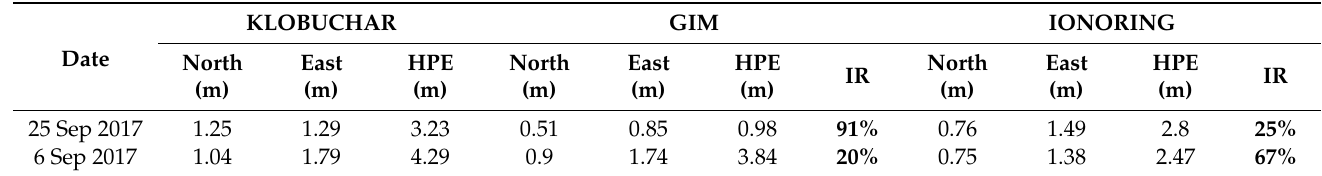
Table 2. Summary table of the positioning results reporting the RMSE of the SPP with respect to the true position (PPP static) and the improvement ratio with respect to the Klobuchar